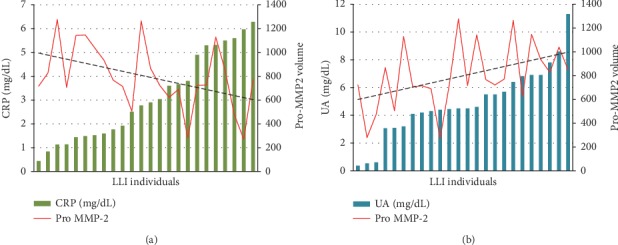
Histograms of Pro-MMP-2 activity levels in the LLI group and hematological values of CRP (a) and UA (b) to show the found correlations. The trend of the line in hematological parameters shows a positive or inverse correlation.